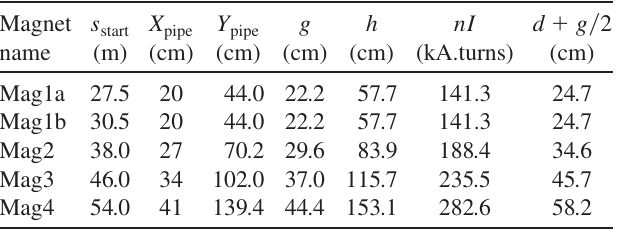
TABLE III. Main properties of the window-frame magnets at the beginning of the CLIC post-collision line.